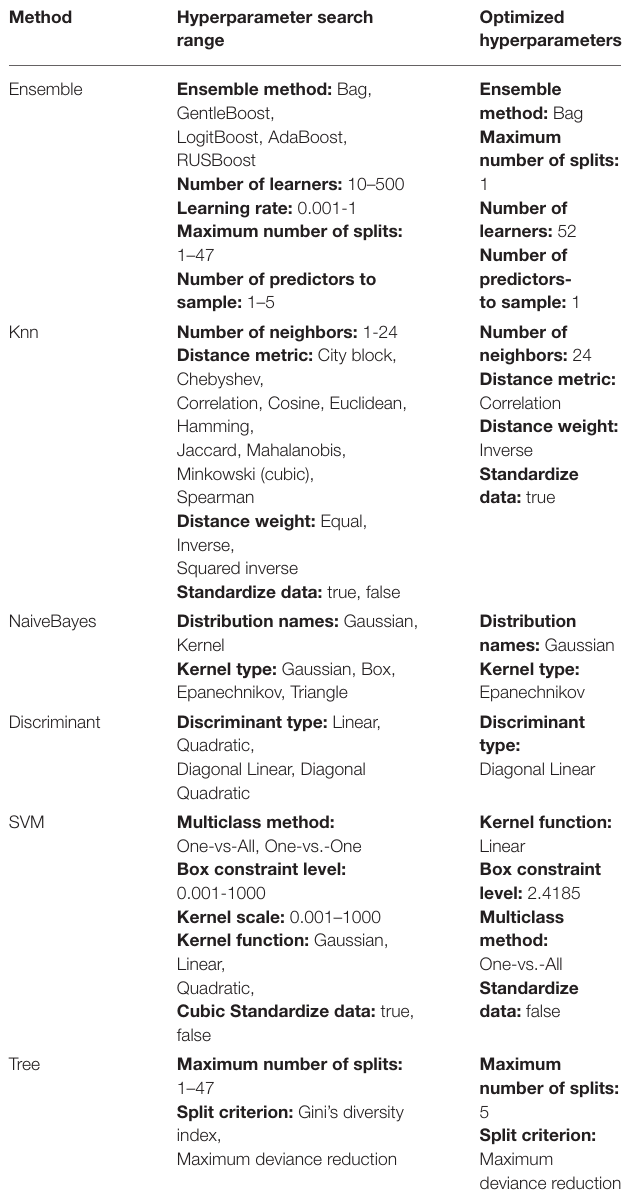
TABLE 1 | Hyperparameters tested/optimized. Method Hyperparameter search